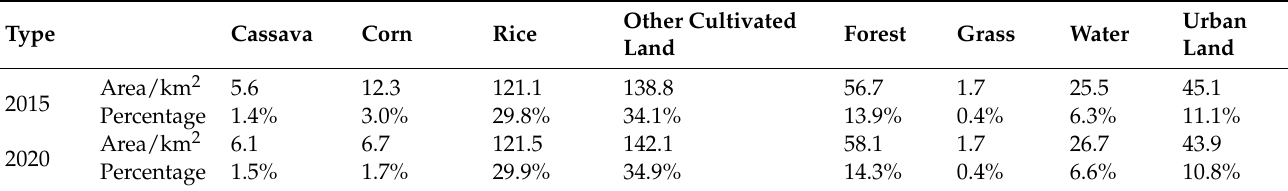
Table 2. Land-use area and proportion of the Yujiang River Basin (km 2 ).